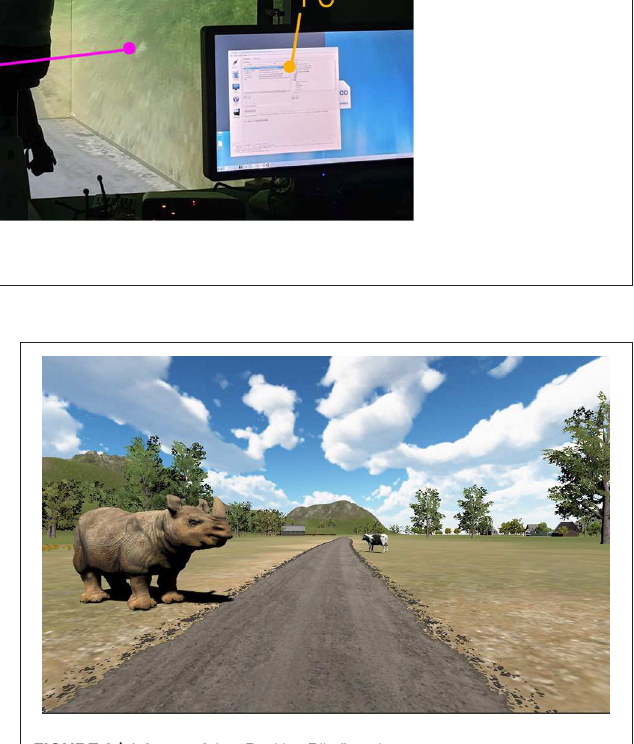
FIGURE 3 | A frame of the “Positive Bike”